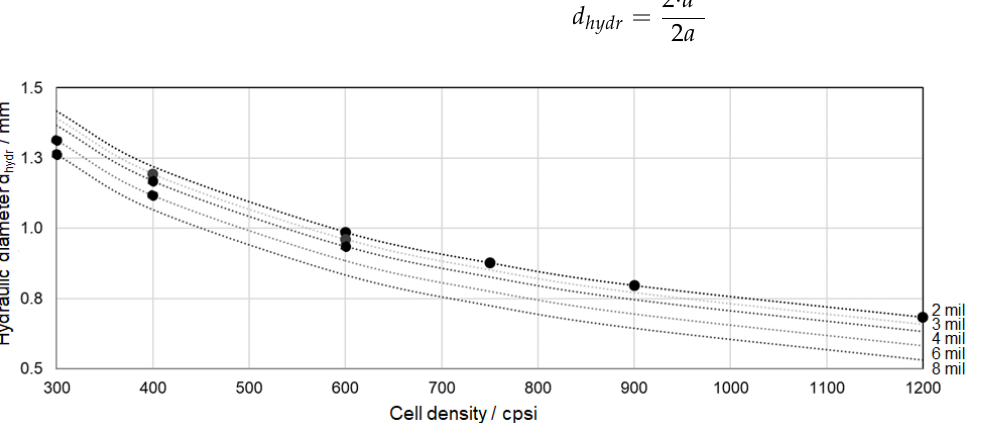
Figure 9. Hydraulic diameters of single channels.